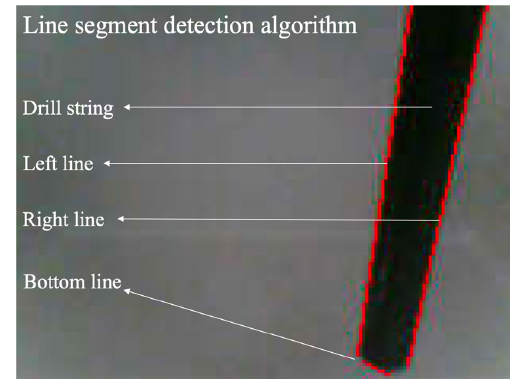
Fig. 14 Quad detection